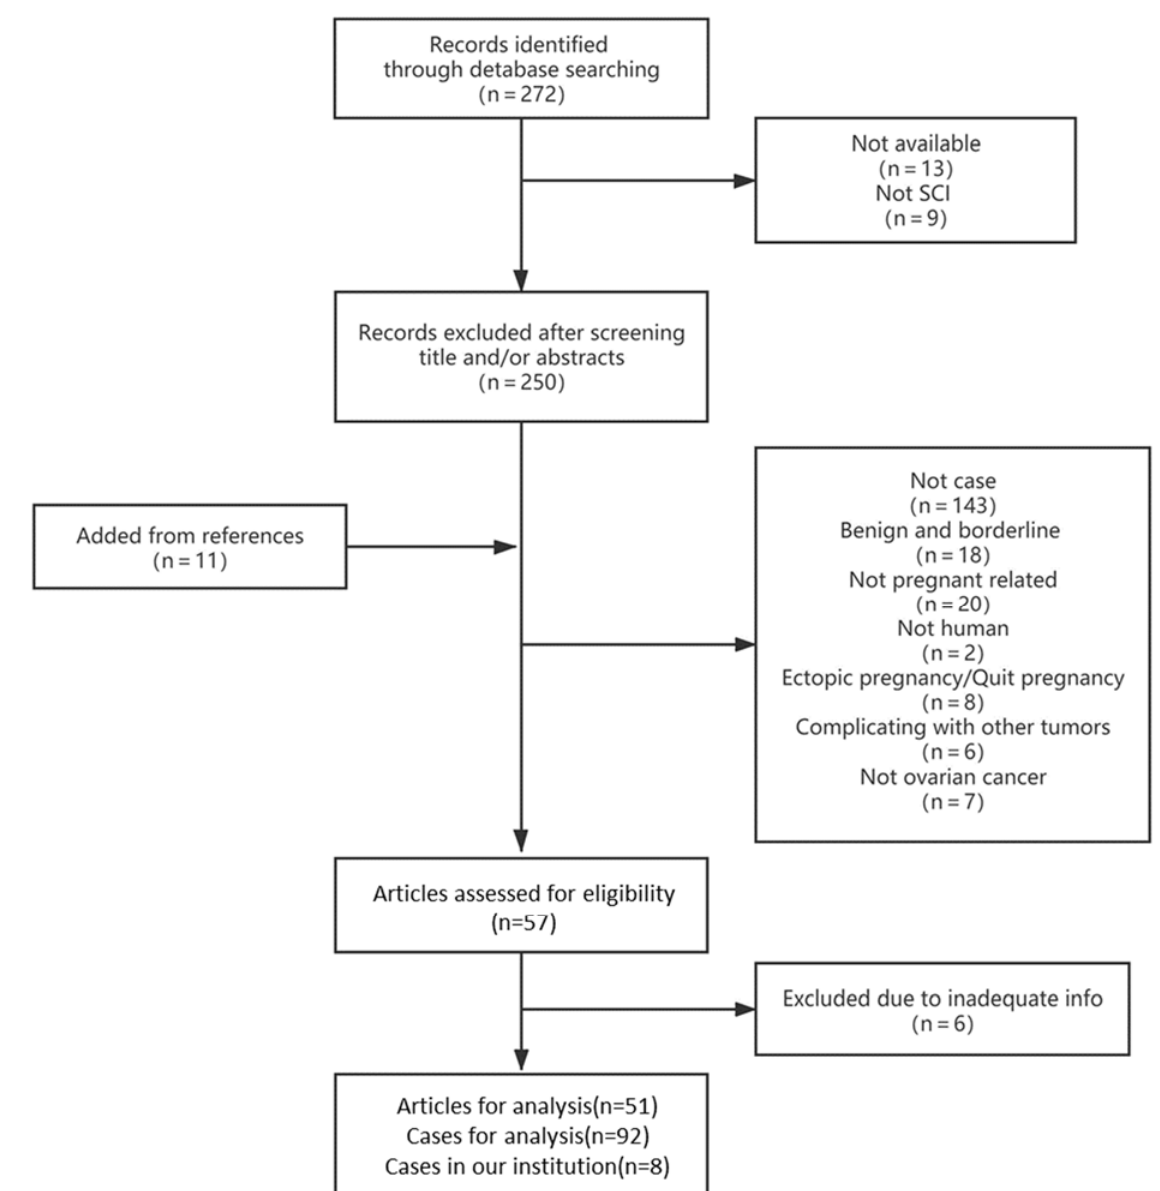
Figure 1. Flow chart showing the selection of the study population.